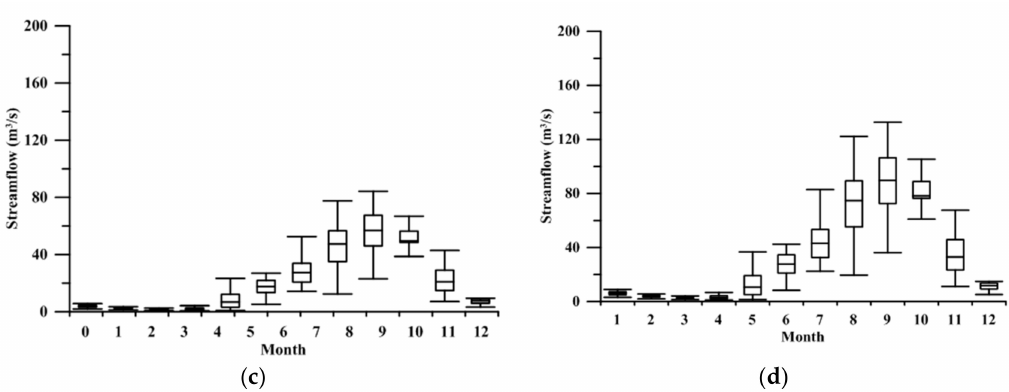
Figure 3. The Box-Whisker plots of the monthly average discharges of the system. ( a ) Thac Mo reservoir, ( b ) Can Don reservoir, ( c ) Srock Phu Mieng (SRPM) reservoir, ( d ) Phuoc Hoa